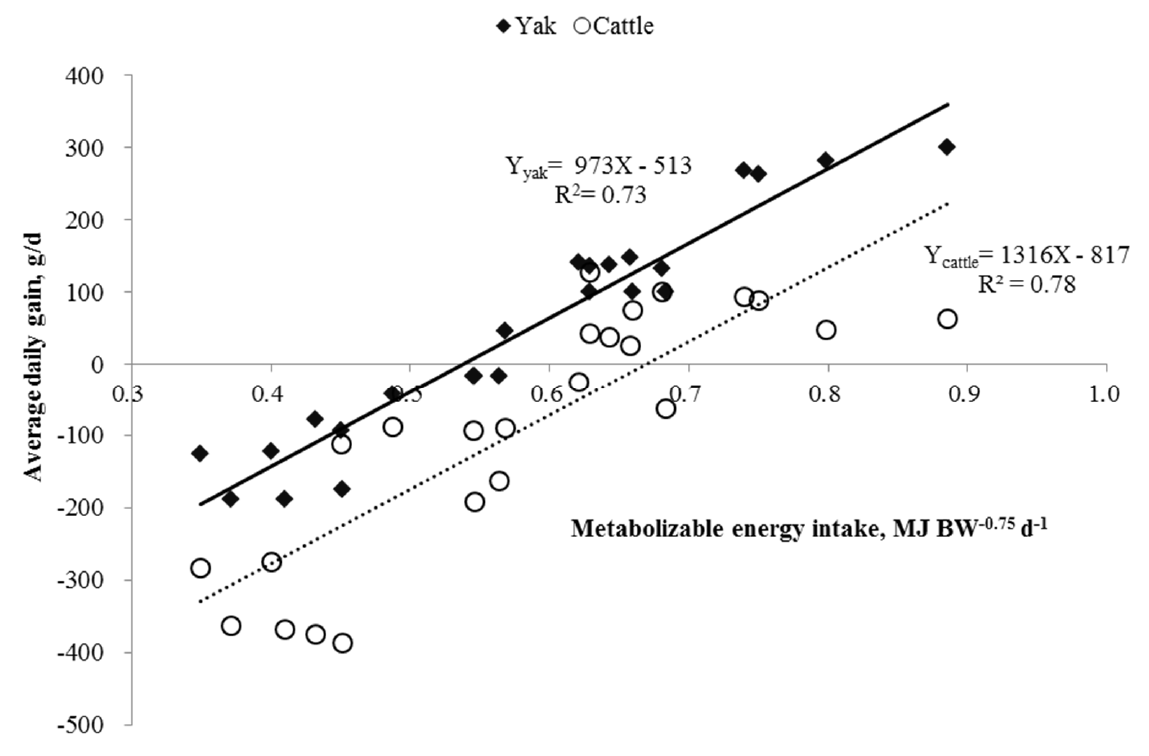
Figure 2. The linear relationship between metabolizable energy intake (MEI) and average daily gain (ADG) in yaks ( ◆ ) and cattle ( ○ ) offered oat hay pellets with different feeding levels. The regression equations were ADG = 973 MEI − 513 (n = 24, R 2 = 0.73) for yaks and ADG = 1316 MEI − 817 (n = 24, R 2 = 0.78) for cattle. Table 2. Apparent digestibilities of dry matter and dietary nutrients in yaks and cattle offered oat hay pellets at different feeding levels.